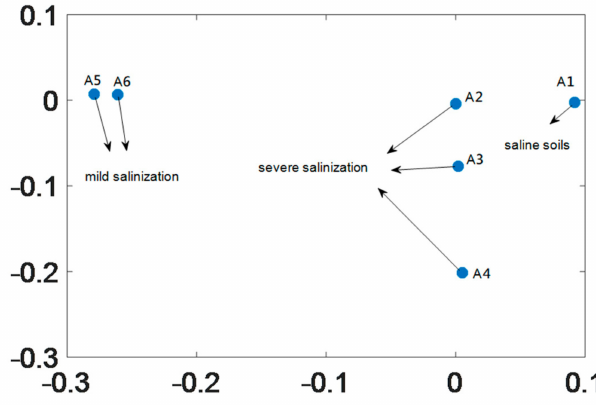
Figure 10. Chaotic attractor distribution for 0.6 order of the six sampling points in Area